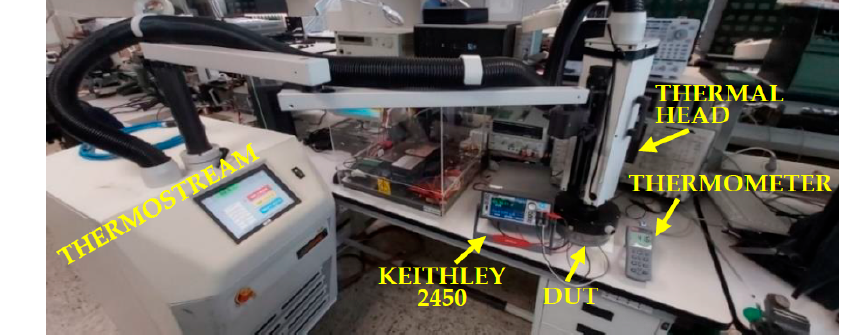
Figure 1. Calibration setup.